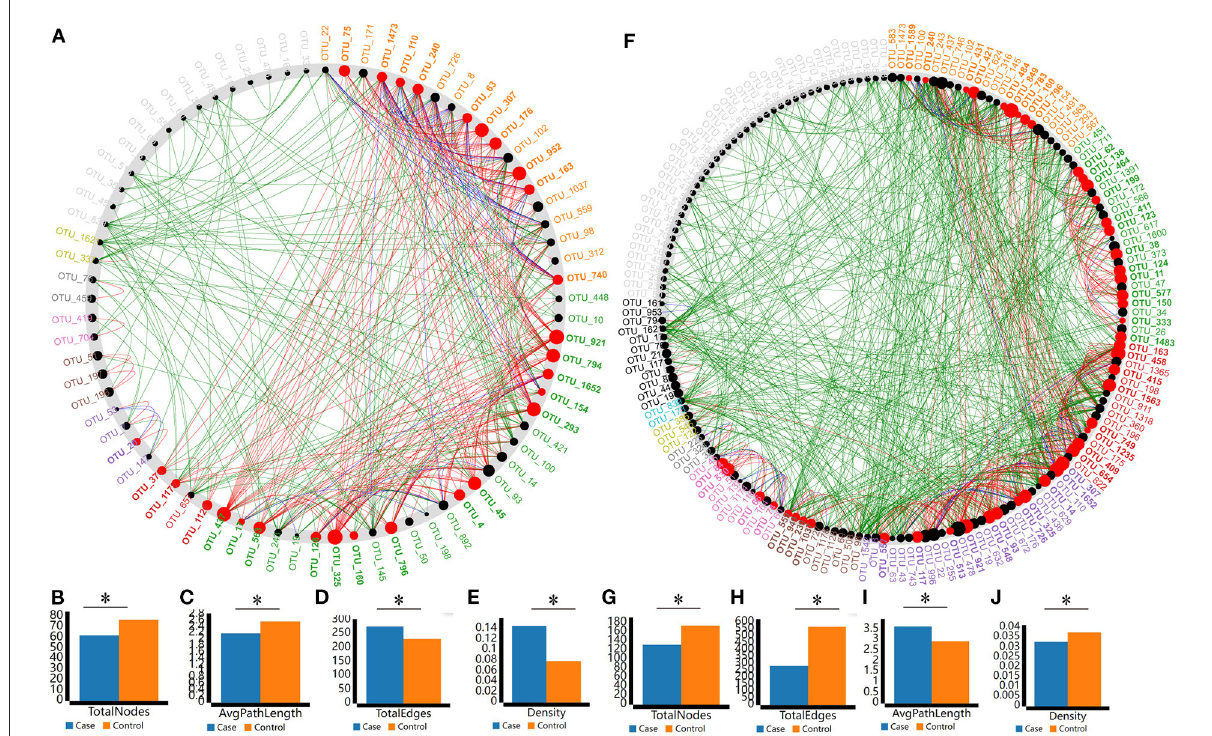
FIGURE4 The microbial correlations were inferred from OTUs abundance profiles using the Spearman method and only the robust and significant (correlation values < − 0.7 or > 0.7 and P < 0.001) correlations were kept for the construction of co-occurrence networks. Potential keystone taxa on the basis of co-occurrence network analyses of microbial communities. Node sizes and colors are proportional to their scaled NESH score (i.e., score revealing important microbial taxa of microbial association networks). The large red nodes in each plot represent particularly important keystone taxa of apple (A) and the intercropping plants (F) . Each node corresponds to the bacterial OTUs, line colors represent the node (taxa) connections as follows: association present only in apple (A) /intercropping plant (F) microbiomes (red edges), association present only in intercropping microbiomes (green edges), and association present in both apple (A) /intercropping plant (F) and SWS microbiomes (blue edges). Bar plots illustrate the comparisons of the total number of nodes (B) , average path lengths (C) , the total number of edges (D) , and the network density (E) between apple and SWS. The comparisons between apple and intercropping plants were illustrated by bar plots of the total number of nodes (G) , average path lengths (H) , the total number of edges (I) , and the network density (J) . * P <